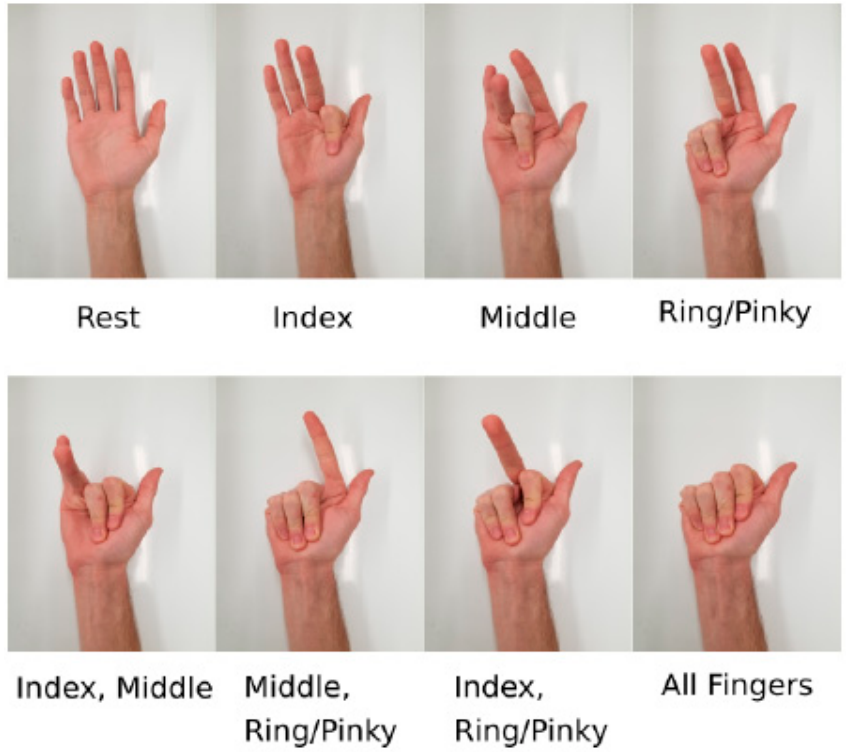
Figure 3. Hand gestures are used for the training of an artificial neural network (ANN) model.